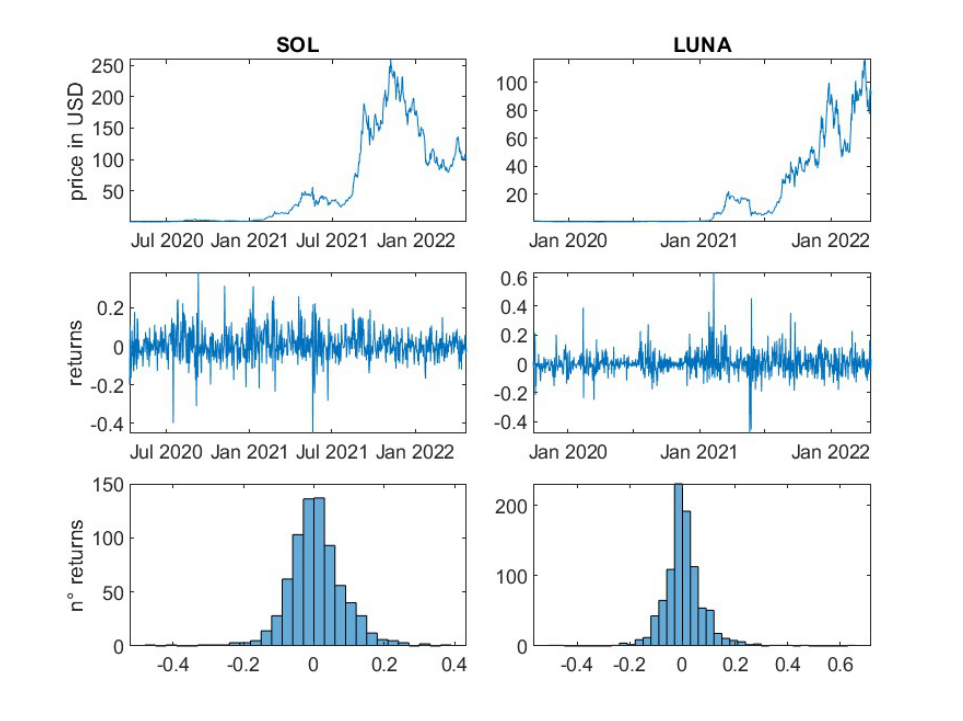
Figure A3. SOL and LUNA daily logarithmic